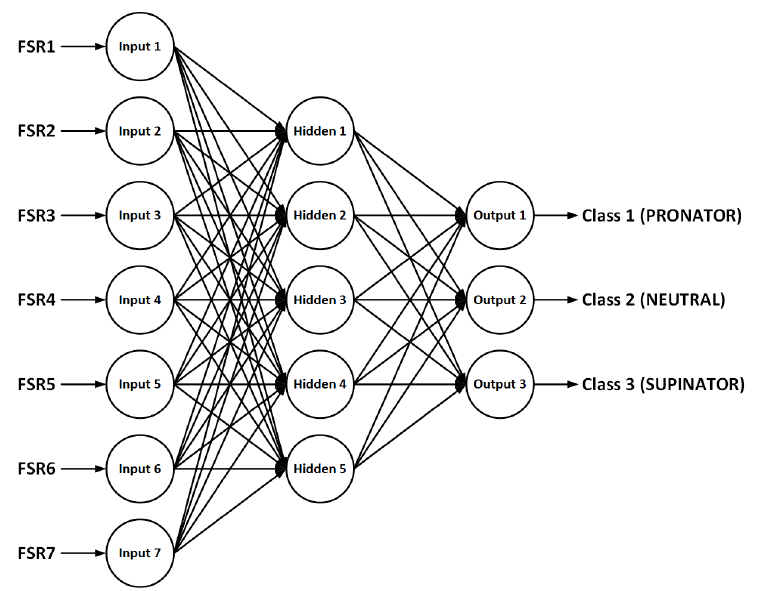
Figure 9. Neural Network